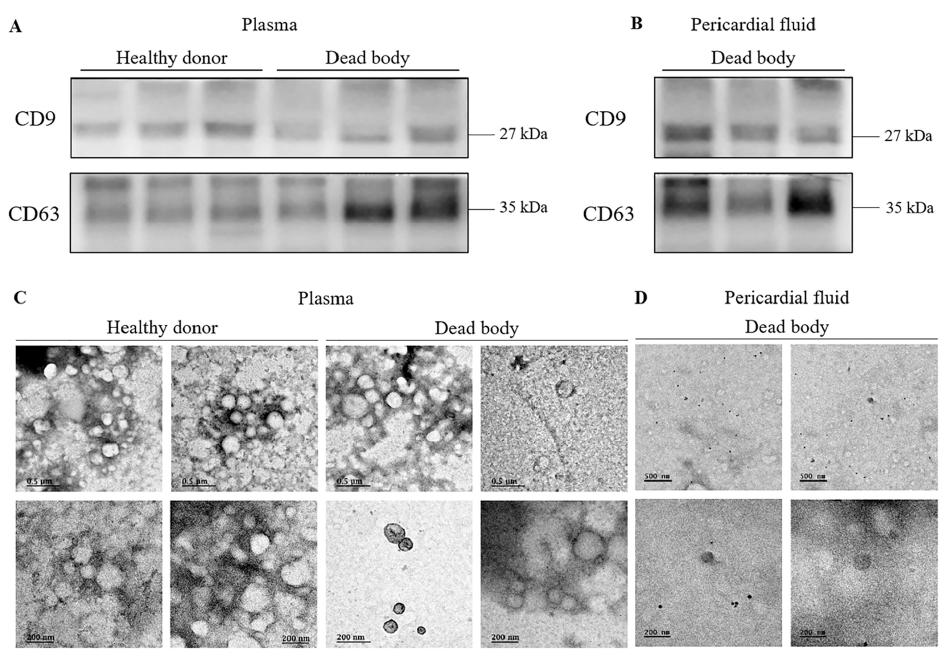
Figure 1. Analysis of the exosome derived from the post-mortem body fluids. ( A ) Western blot performed on three different samples of exosomes isolated from the plasma of healthy donors (n = 3) and dead bodies (n = 3), and ( B ) the pericardial fluid of dead bodies (n = 3) to detect exosome surface proteins (CD9, CD63). ( C ) Transmission electron microscopy images of exosomes derived from the plasma of healthy donors and dead bodies, and from ( D ) the pericardial fluid of dead bodies. The scale bar = 200 nm or 500 nm (0.5 μ m).